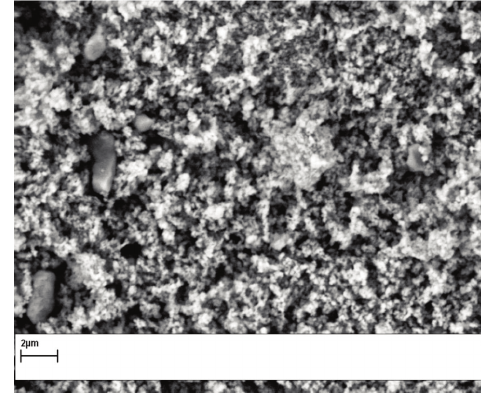
Fig. 1 ­ Images of nanosized TiO Microscope (STM).